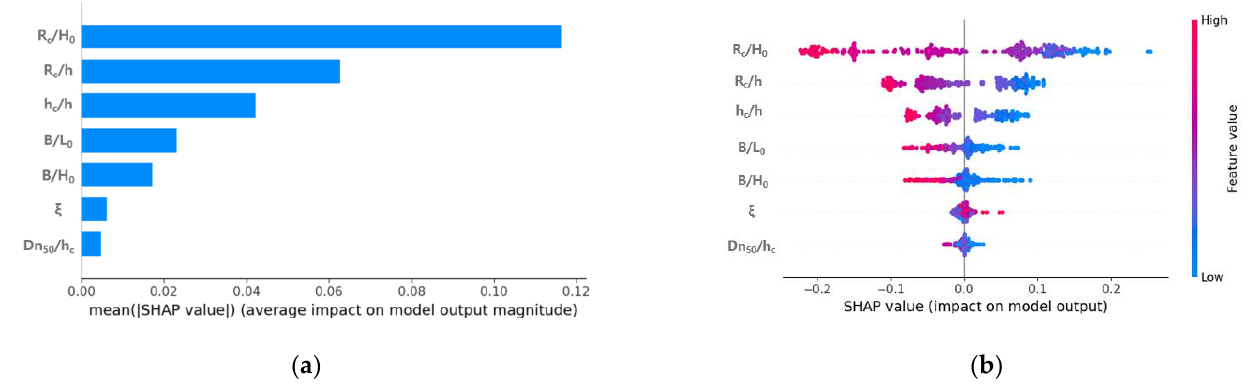
Figure 6. Results for the new data set.